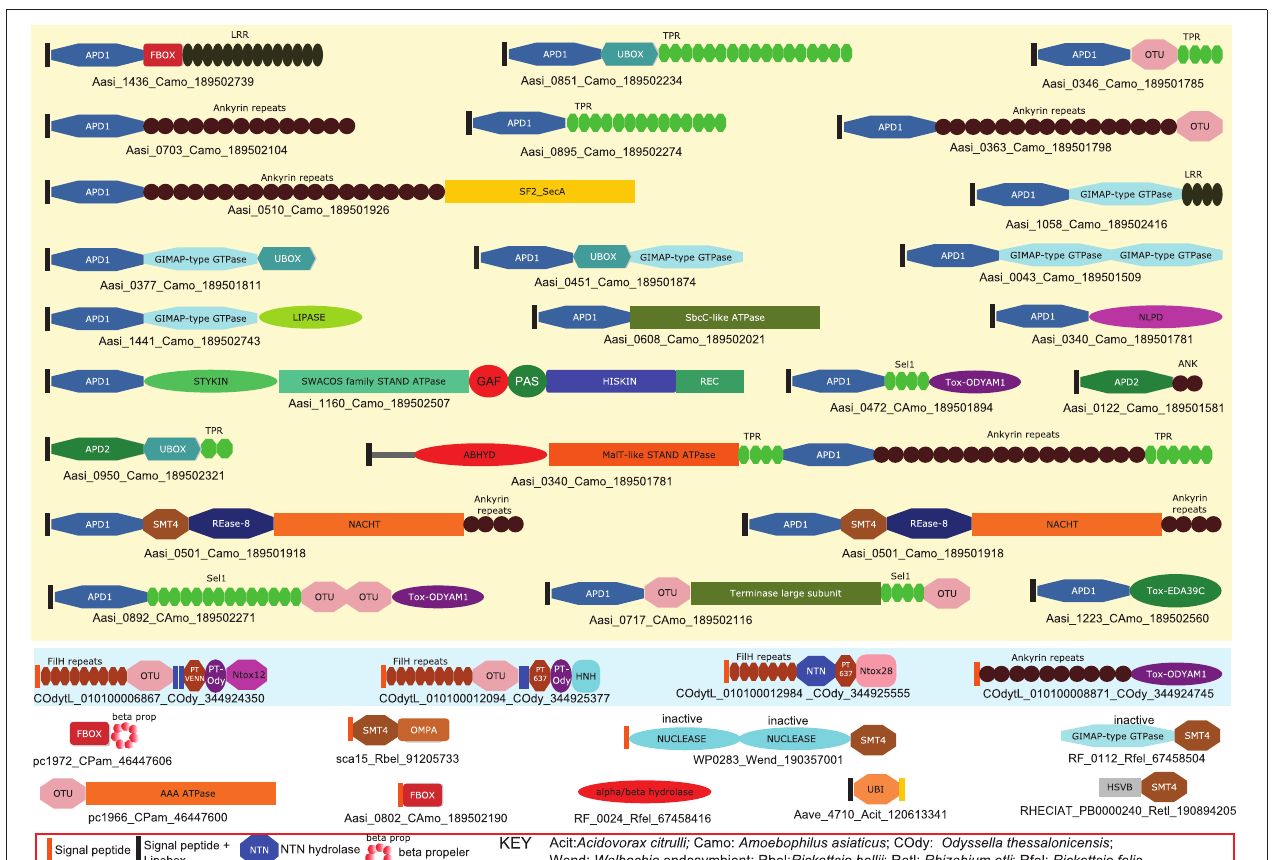
FIGURE 2 | Domain architectures of effectors deployed by endosymbiotic/parasitic bacteria illustrating certain common functional strategies. Proteins are labeled by their gene names, species abbreviations and genbank index (GI) numbers separated by underscores. Non-standard domain names and expansion of species abbreviations are given in the key